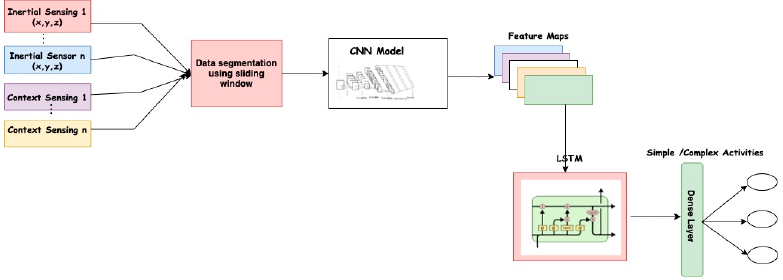
Figure 2. High-level view of the hybrid model with sensory signals from various